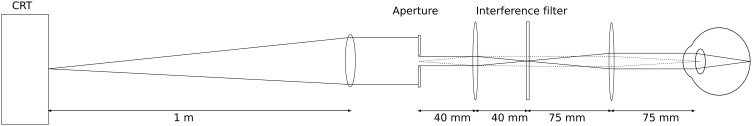
The optical system used to relay the stimulus on the CRT to the observer's retina. An aperture was used to control the observer's effective pupil size and an interference filter was used to reduce chromatic effects. The dotted line shows optical path relaying the aperture to the observer's pupil.